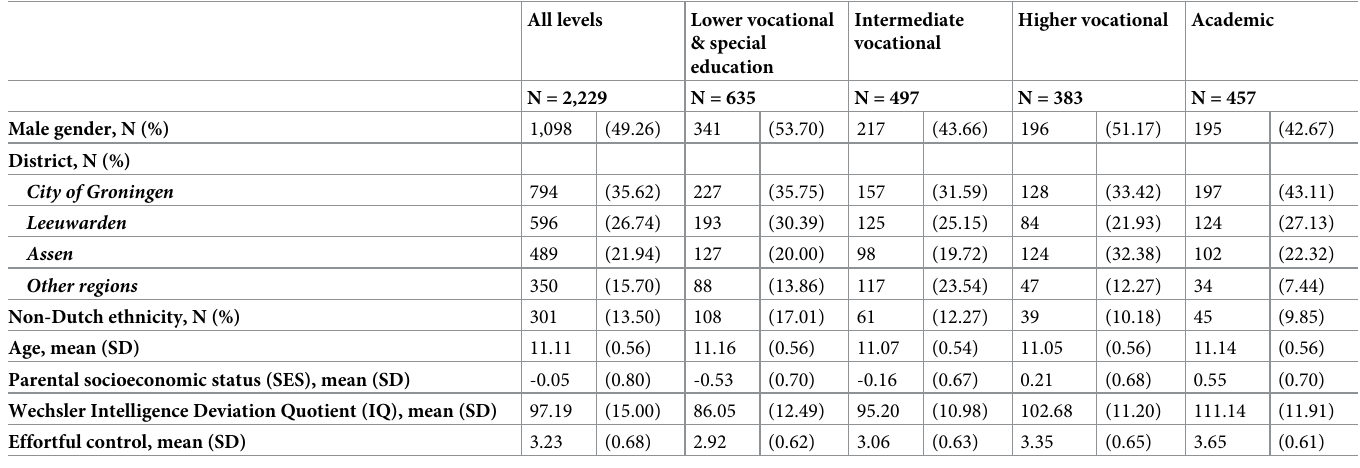
Table 1. Characteristics of adolescents participating in the TRAILS Study (the Netherlands, 2000–2017, N = 2,229) at wave 1 (2000–2002) and according to educa- tional level at wave 2 (2003–2005).